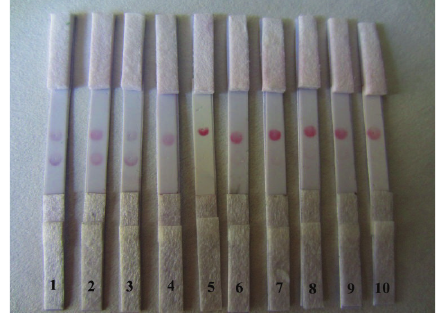
Figure 8: The results of the immunochromatographic strip assay. (1) Chujianghongsurimi. (2) Rizhao natural surimi. (3) Feihua- surimi. (4) Hongyesurimi. (5) Jinhai red sea bream surimi. (6) Jinhaihairtailsurimi. (7) Wenlingsurimi. (8) KISIMEX surimi. (9) Haizhiweisurimi. (10) Negative